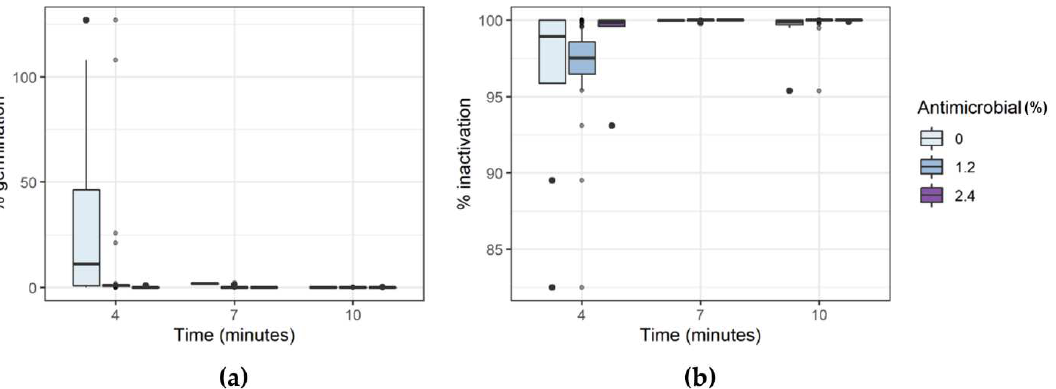
Figure 5. Percentage variation of germination ( a ) and inactivation ( b ) of C. pasteurianum LMG 3285 spores after exposure to DoE conditions.